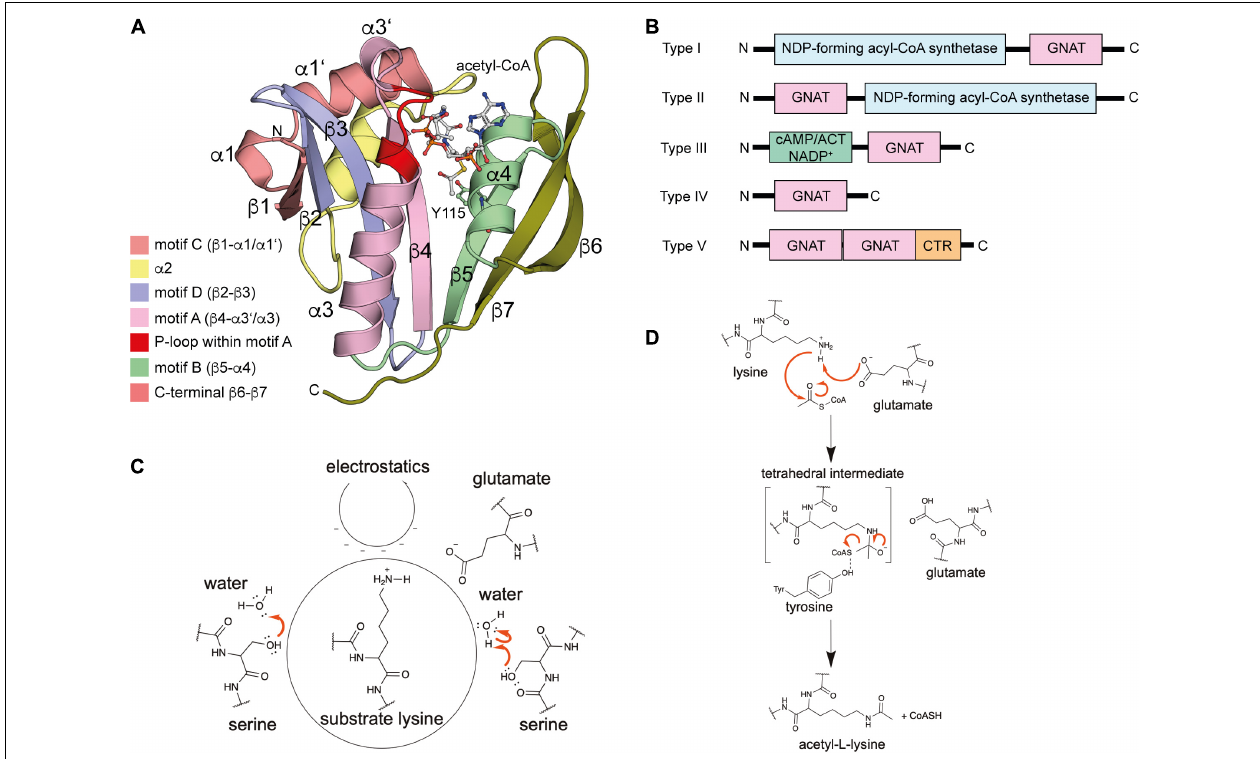
FIGURE 2 | Enzymatic protein ac(et)ylation is catalyzed by GNAT ac(et)yltransferases in bacteria. (A) Structure of the E. coli GNAT acetyltransferase RimI in complex with acetyl-CoA (PDB: 2CNS). All bacterial protein acetyltransferases belong to the GNATs. These are characterized by sequence motifs A-D as indicated. Motifs A and B are important for CoA-binding. Motif A contains the characteristic sequence motif Arg/Gln-x-x-Gly-x-Gly/Ala (x: any amino acid), known as P-loop, which contacts the phosphates of the acetyl-CoA/CoA. The acetyl-CoA is shown in ball-and-stick representation [the figure was generated with PyMOL